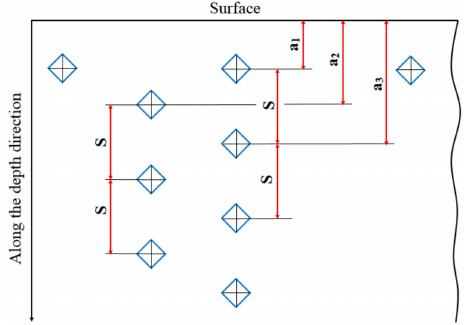
Figure 1. Locations of the hardness indentations.